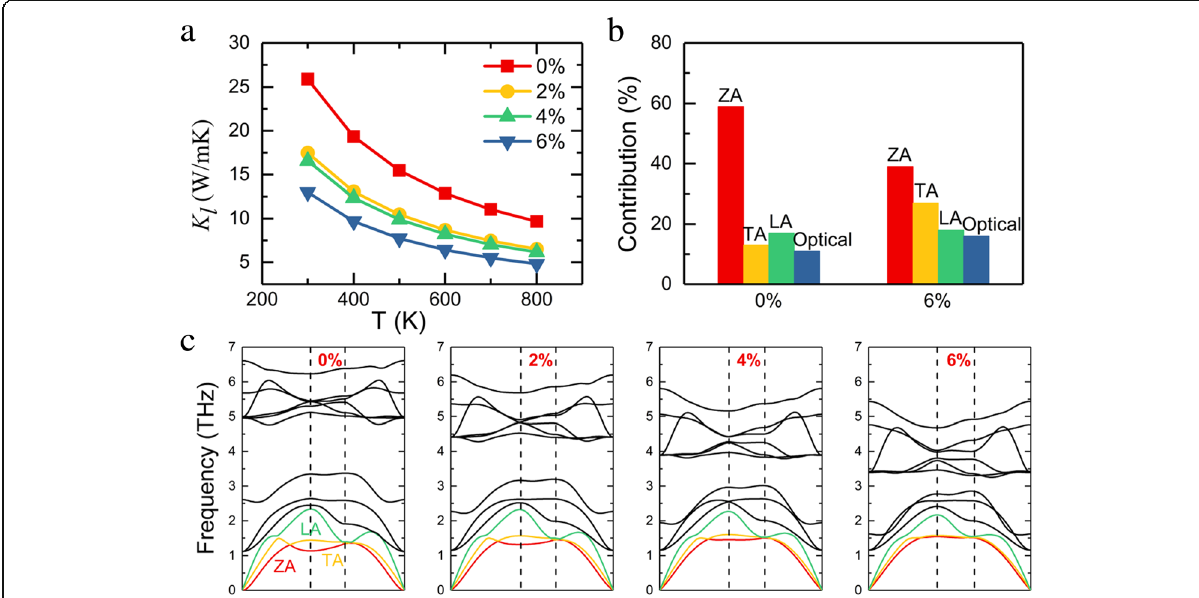
Fig. 4 a Calculated biaxial strain effects on lattice thermal conductivity at different temperatures. b Contribution of the ZA, TA, LA, and all optical branches towards the lattice thermal conductivity for unstrained and 6% strained systems. c The phonon dispersion curves of the monolayer InSe for different